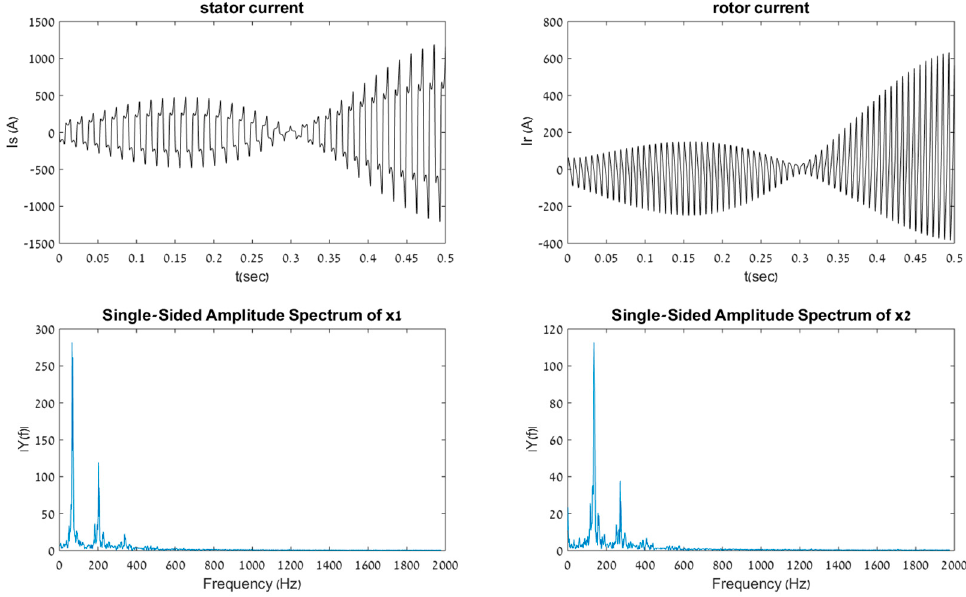
Figure 17. A computer simulation of IG with L s = 0.21 H, with rotor current and FFT.